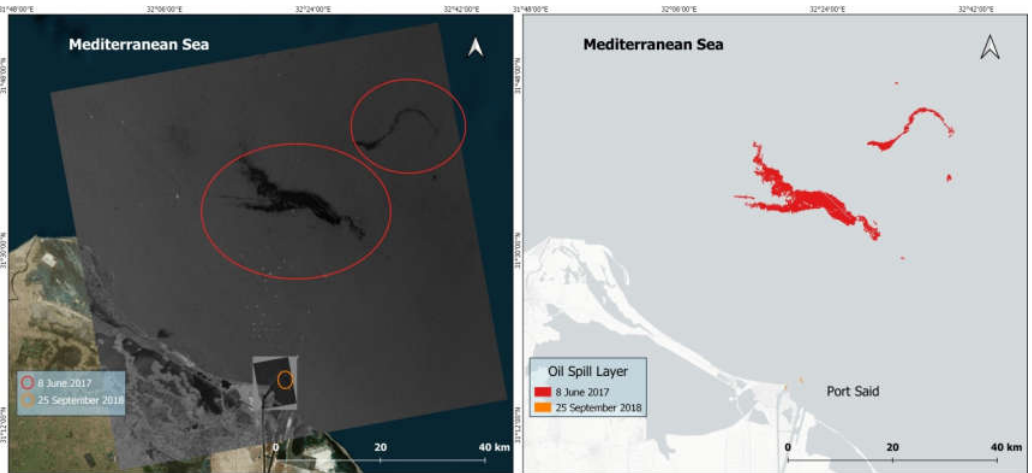
Figure 6. Left—is the preprocessed raw data: result after speckle filtering and geometric correction. Middle—is the masked oil spill area after processing and clustering the SAR image based on a predefined threshold of 2 decibel. Right—is the vector conversion of the raster oil spill mask to be enable area and other geographical calculations. Figure 7. The capability of the model to detect the largest oil spill event near the entrance of the Suez Canal at Port Said city, which happened on 8 June 2017, with an actual mask of the oil layer with an area equals 94 km 2 and the smallest oil spill event detected, which happened on 25 September 2018, at the Canal entrance with an area of 0.3 km 2 .